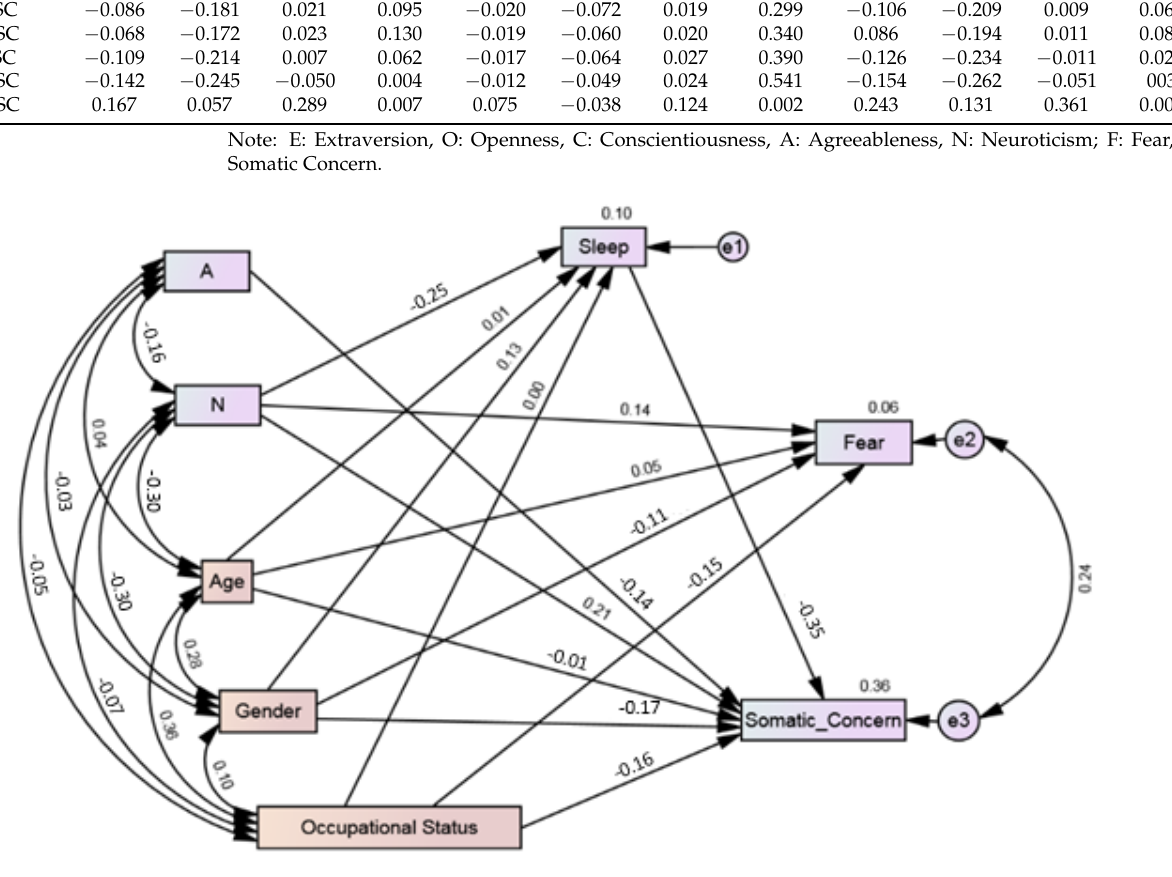
Table 4. Standardized effects and corresponding 95% bias-corrected bootstrap CIS for model 1.